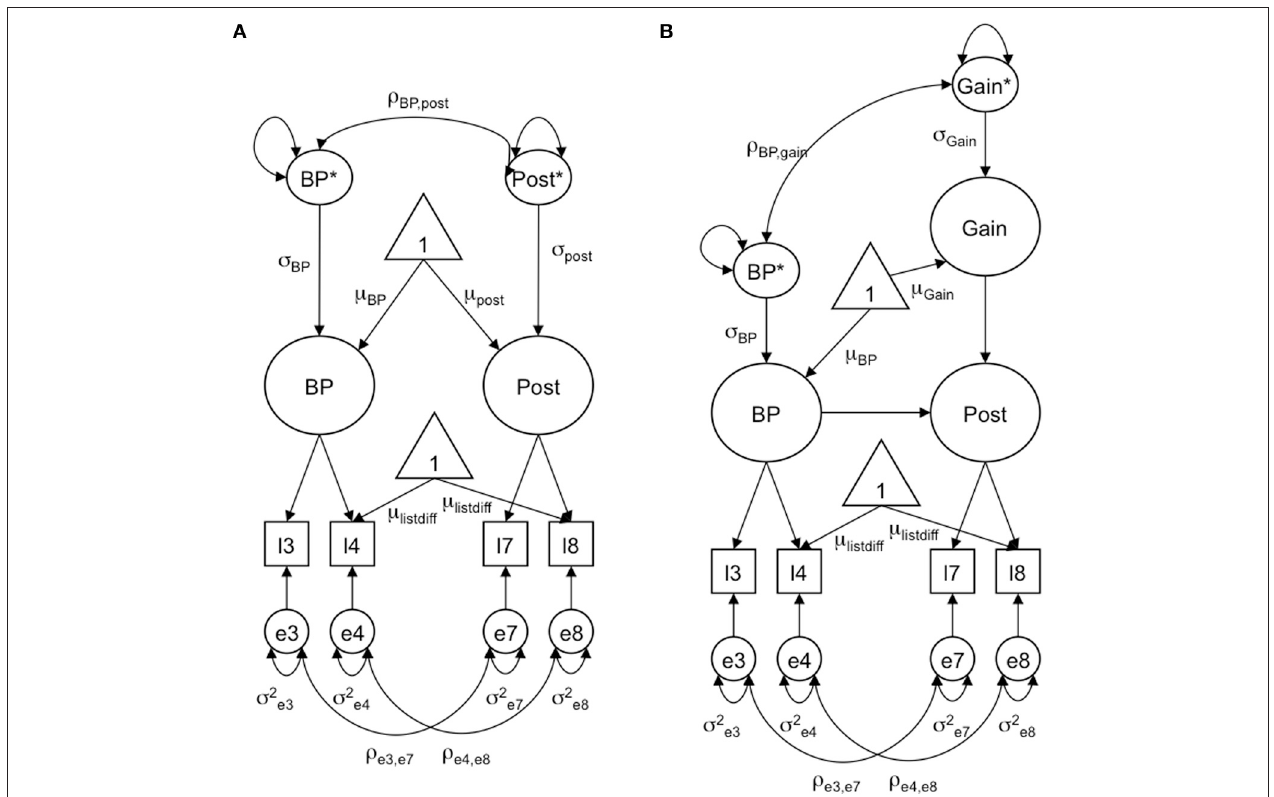
weights by one-headed arrows, and variances and covariances by two-headed arrows. The triangle indicates means. Unlabeled parameters are fixed to 1. BP, baseline performance; POST, post-instruction performance; l,